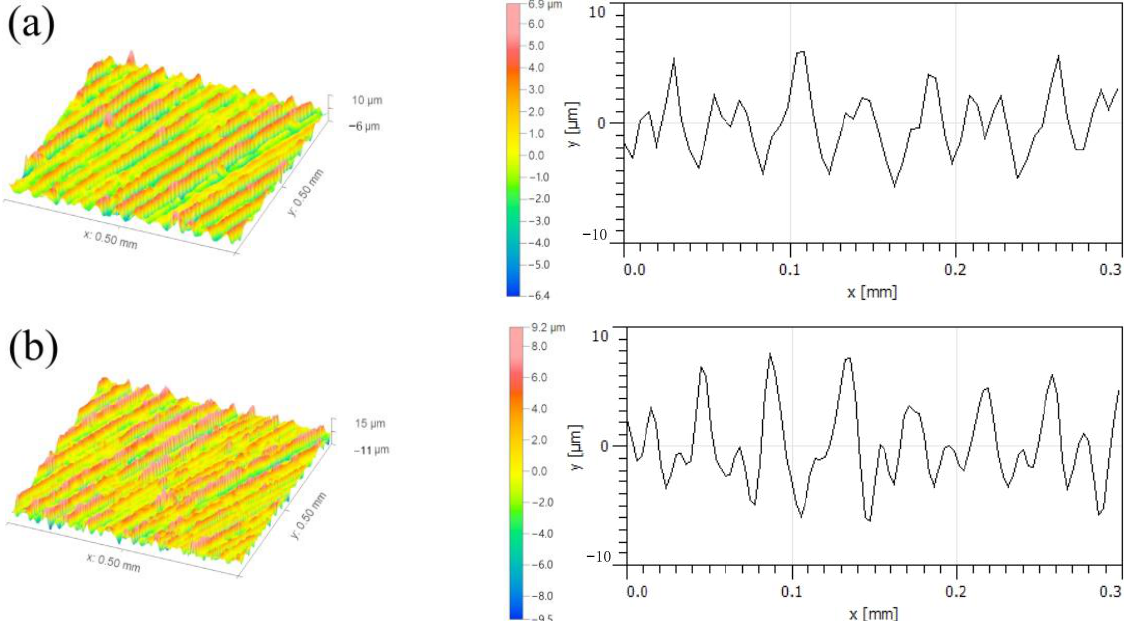
Figure 18. Micro-morphologies of machined surfaces at different axial cutting depths: ( a ) a p = 0.5 mm; ( b ) a p = 1.3 mm.